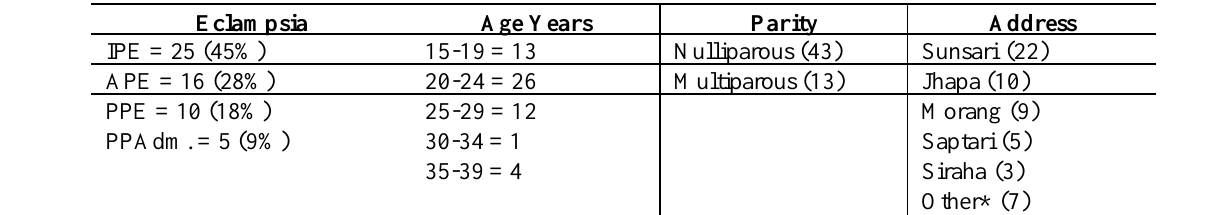
Table I : Maternal baseline characteristics (n = 56)